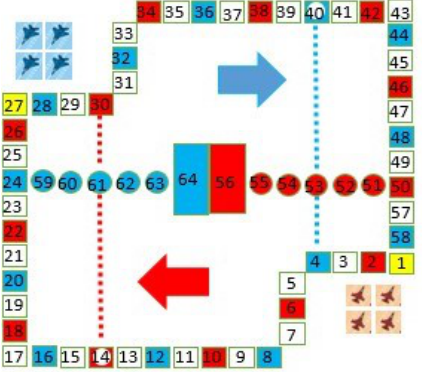
Figure 2. The definition of a chess position on the